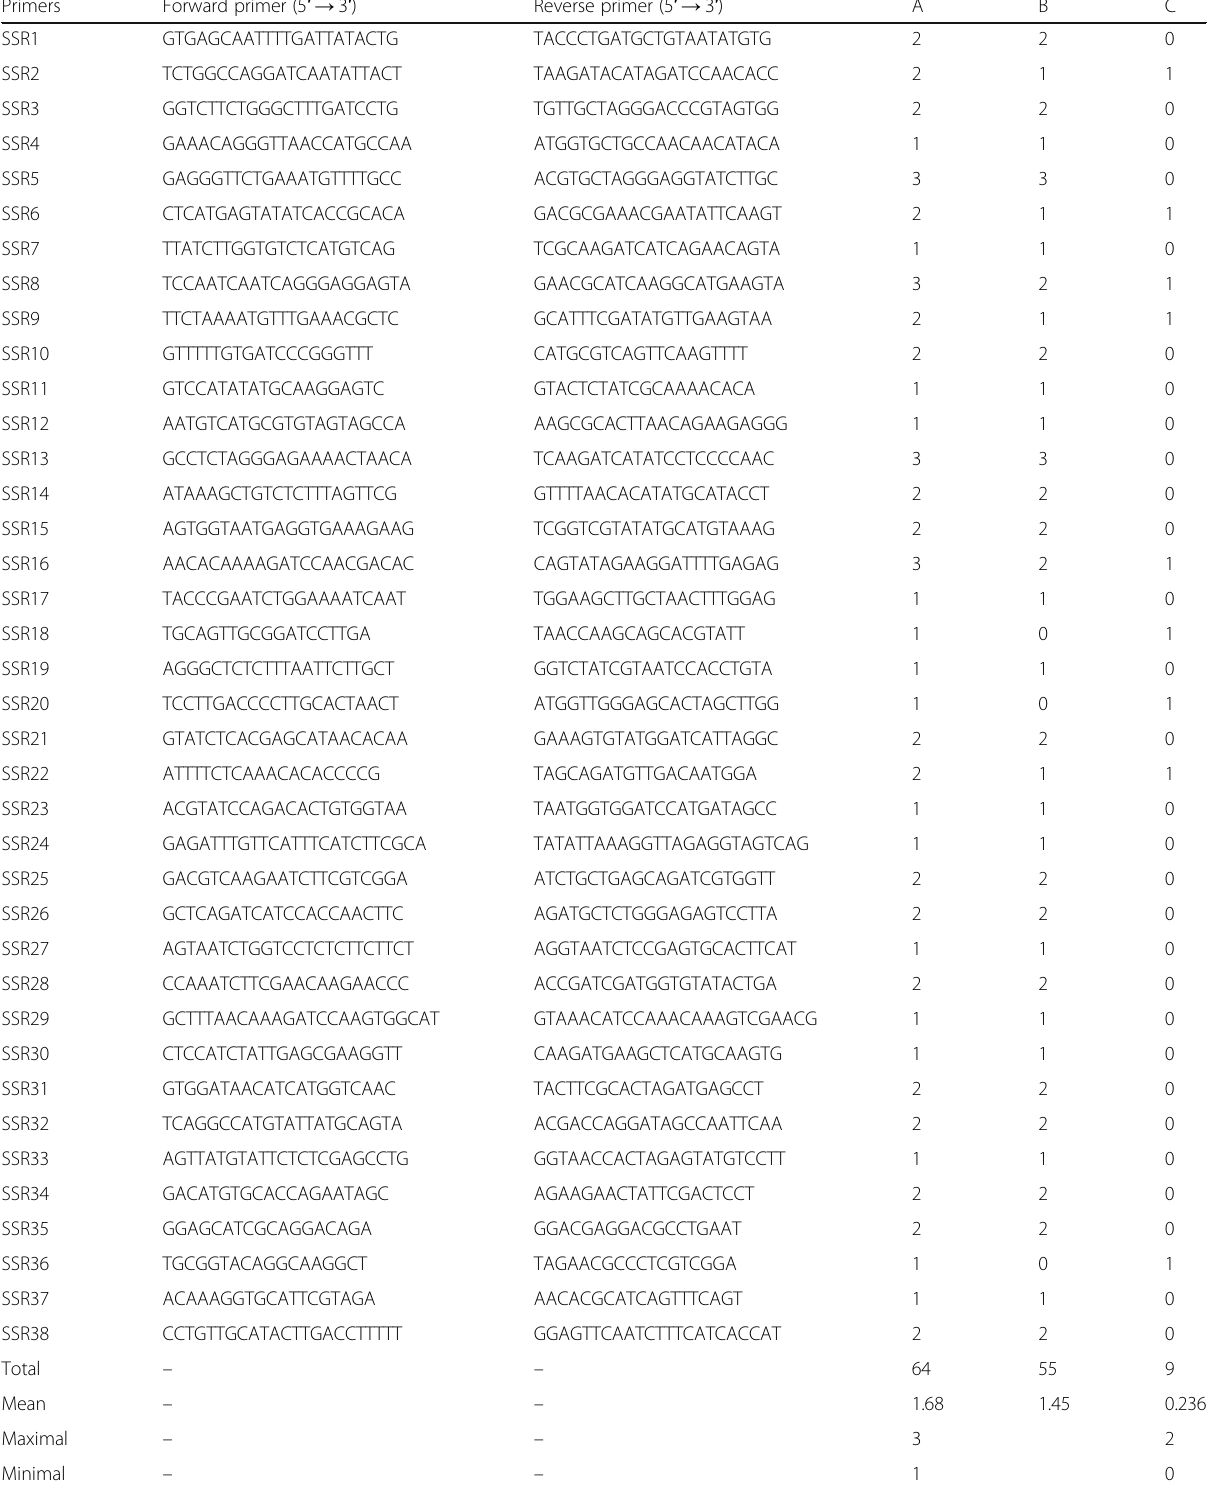
Table 3 Amplification products generated with SSR markers among mother plant and in vitro raised plants